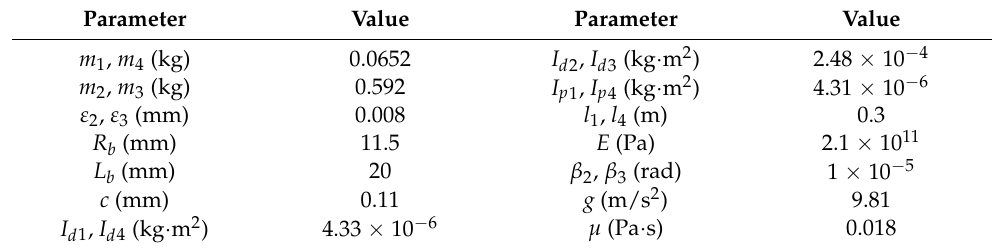
Table 2. System parameters in the dynamic